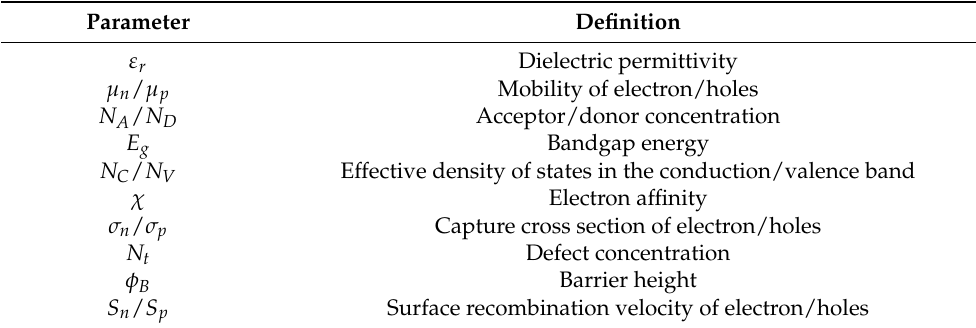
Table A3. Definition of the Parameters Used During the